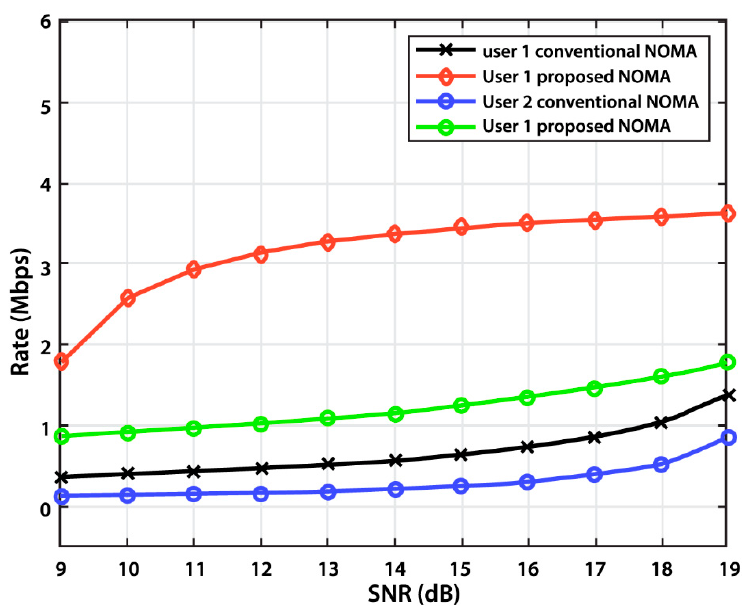
Figure 10. Outage probability against the SNR.